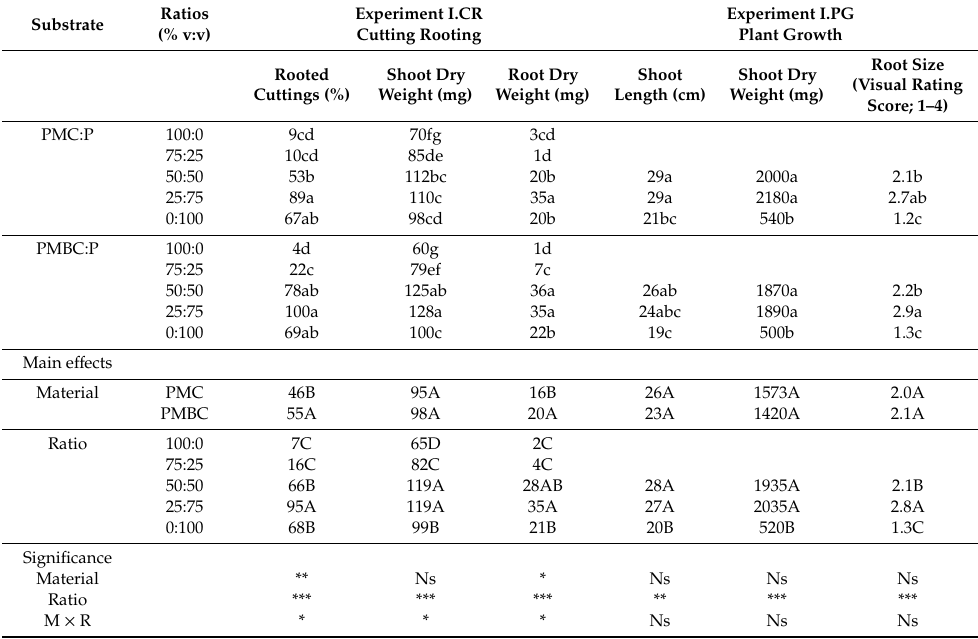
Table 4. Cutting rooting (experiment I.CR) and plant growth (experiment I.PG) of Rosmarinus officinalis as affected by poultry manure composted without biochar (PMC), poultry manure composted with biochar (PMBC), and peat (P) containing growth media. Main effects and statistical significance according to factorial analysis of variance. Three replicates (n = 3) were used for each substrate and ratio.